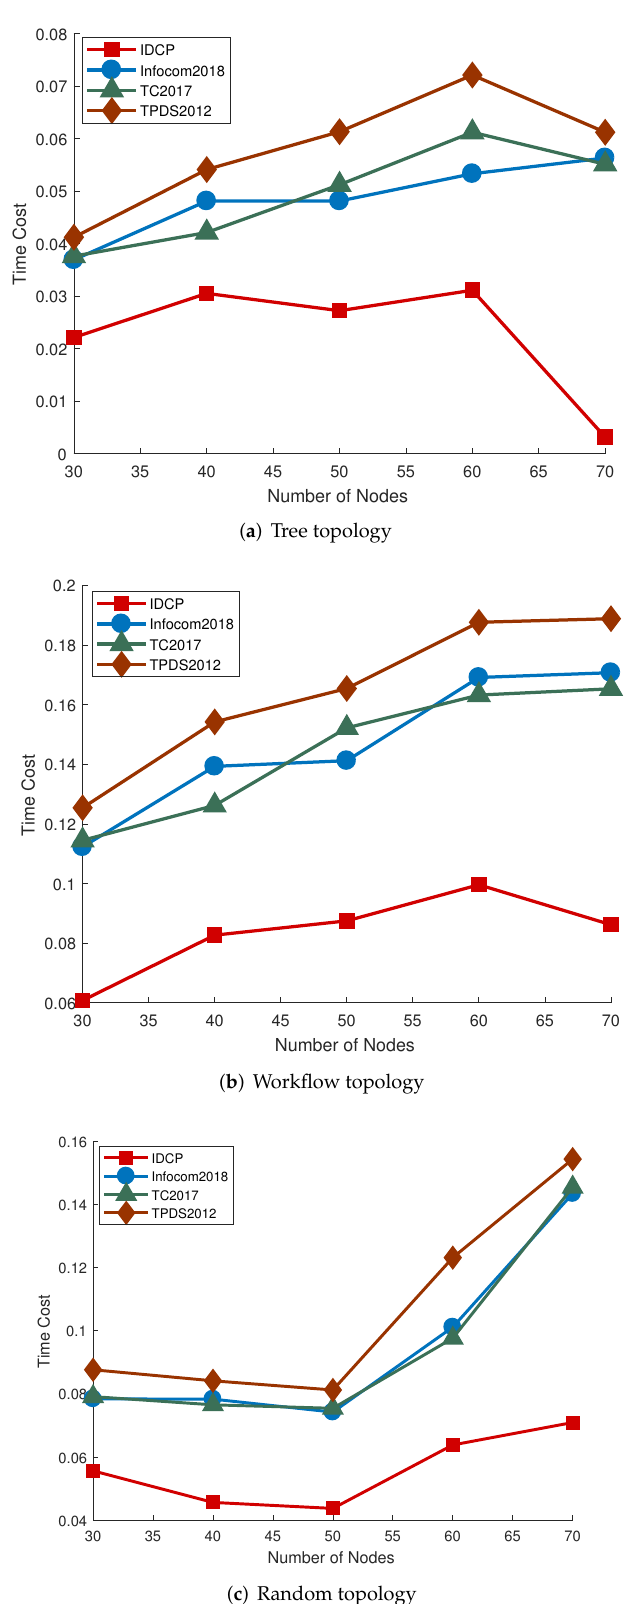
Figure 5. Time cost of different topologies under the number of